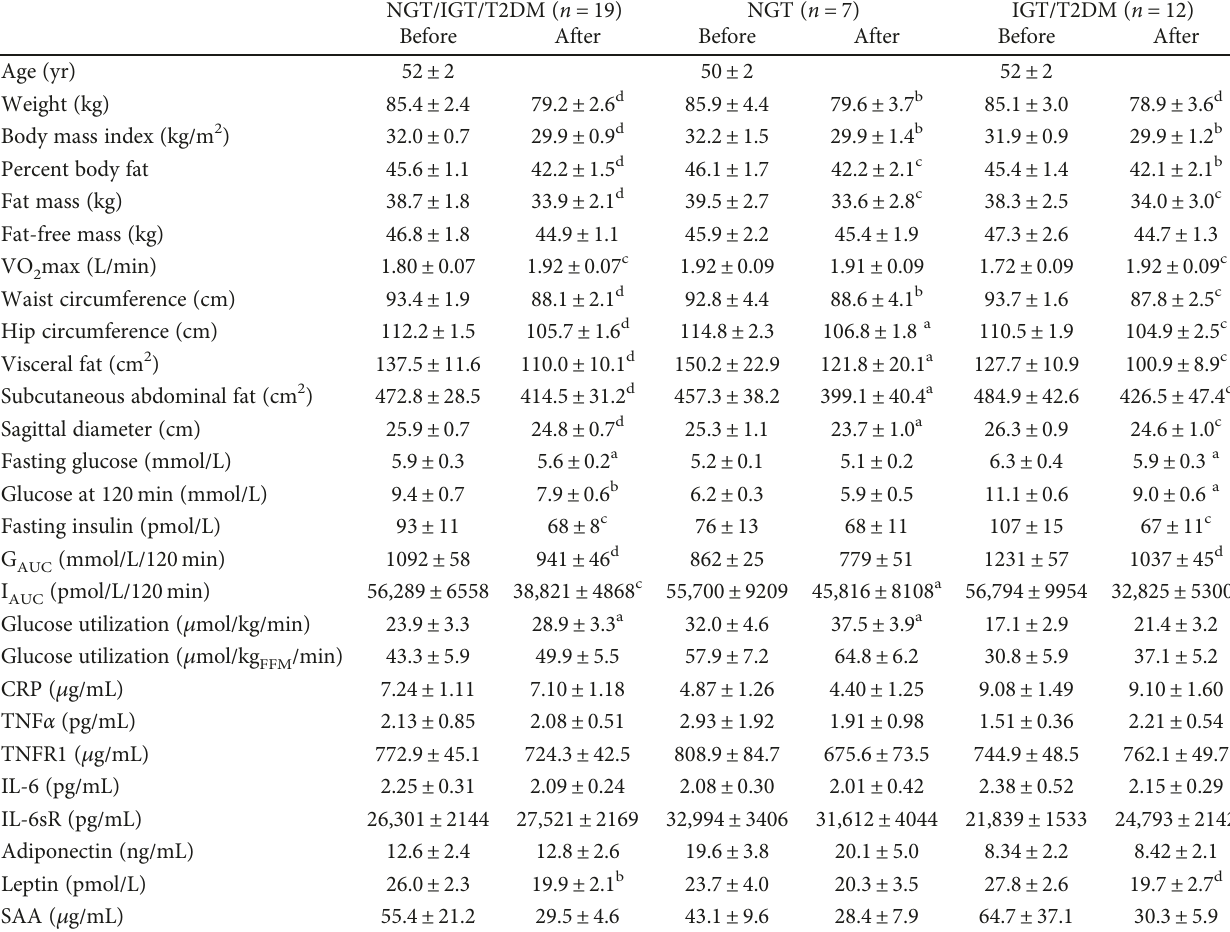
Table 2: E ff ects of the interventions on body composition, glucose metabolism, and in fl ammation. Before After Before After Before